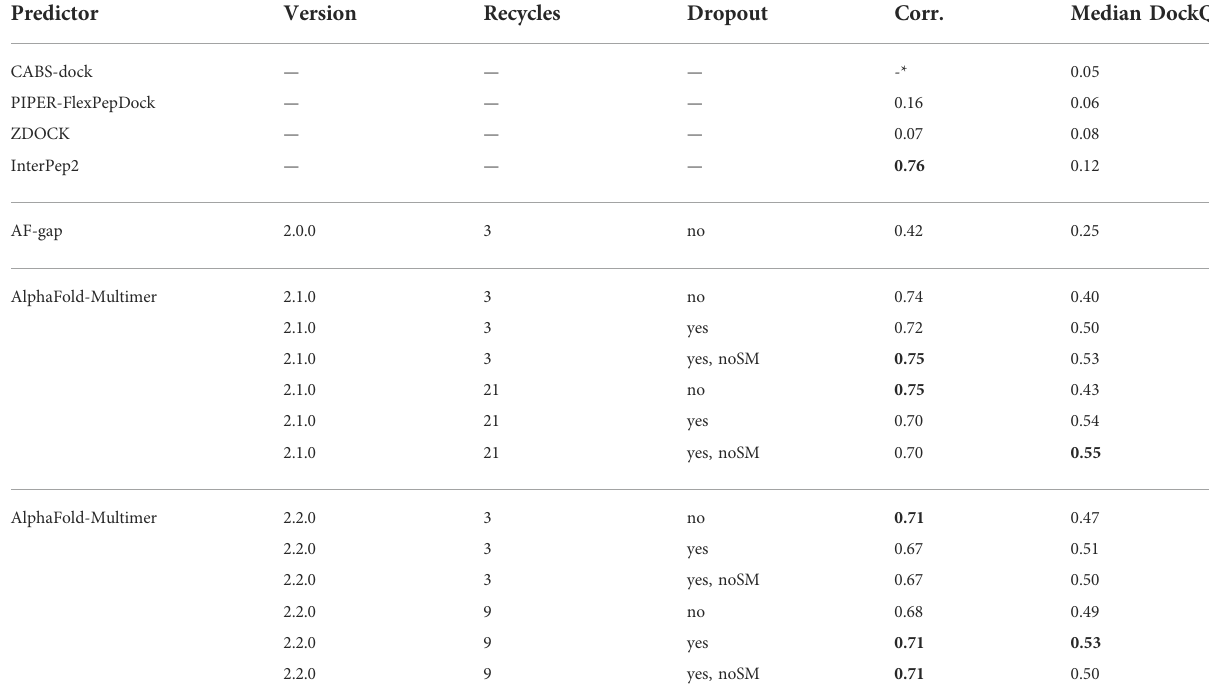
TABLE 2 Summary of results for different methods and settings. Corr . is the correlation between reported scores and DockQ, Median DockQ is the median DockQ when selecting rank 1 for each target.The best values for a particular group are highlighted in bold. *CABS-dock does not output any score: it only returns ranked